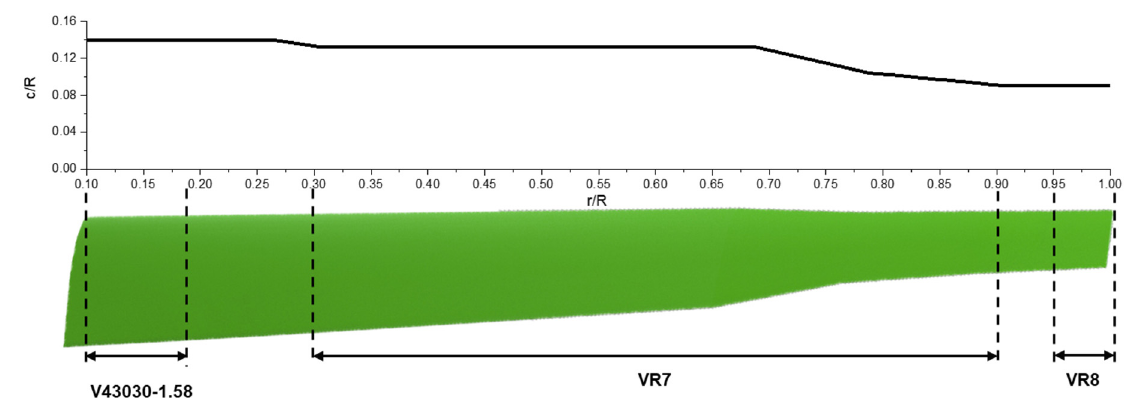
Figure 5. Advanced technology blade of the XV-15 tiltrotor.